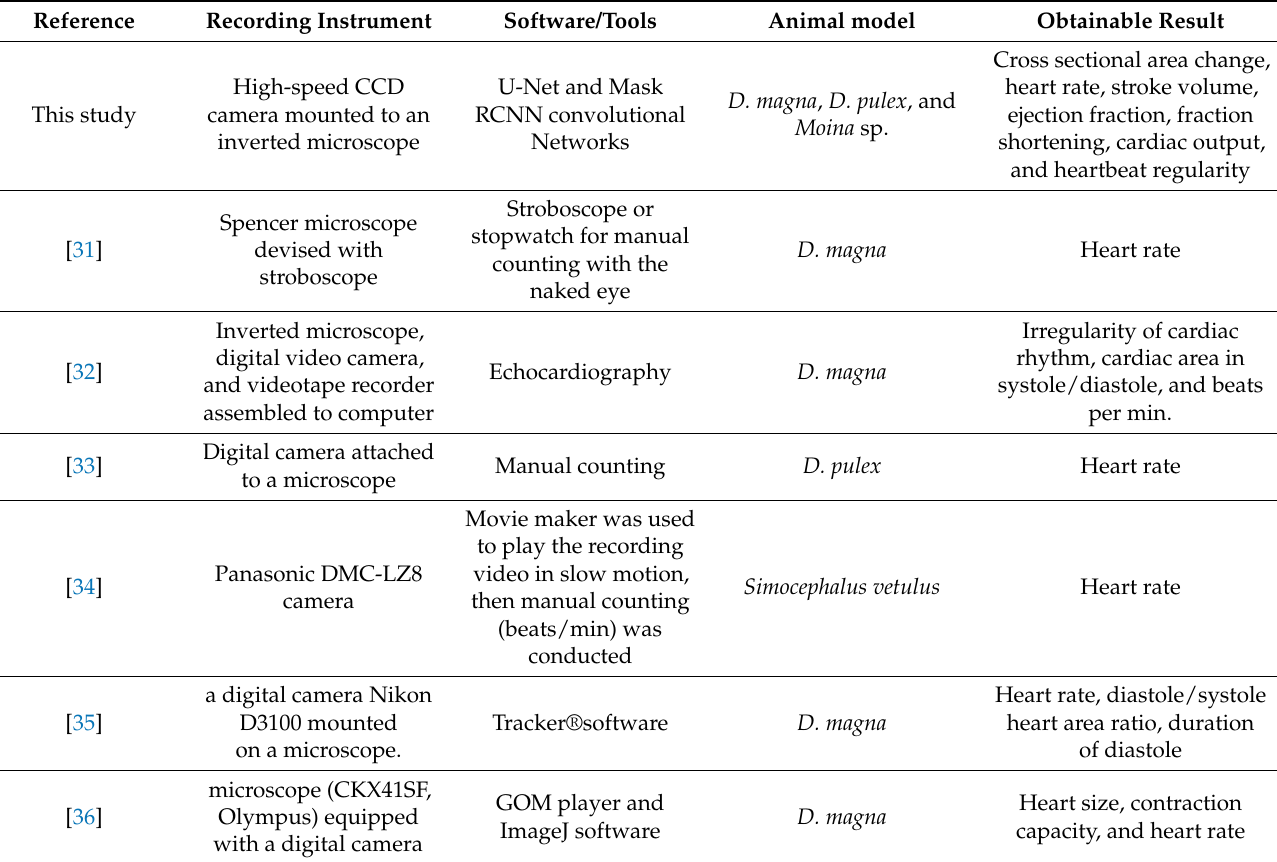
Table 1. Comparison of previous cardiac physiology measurement methods in